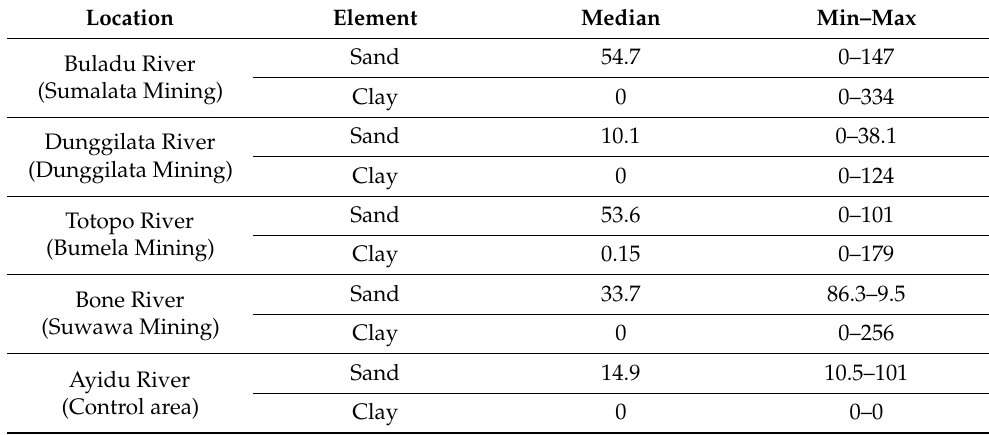
Table 1. Concentration of Hg ( µ g/g) in river sediment sample from ASGM and control area.